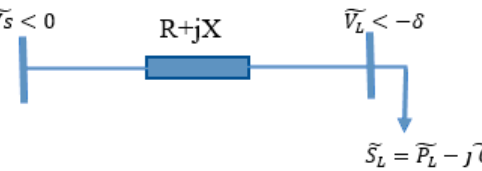
Figure 3. Single transfer line diagram considering load uncertainty.